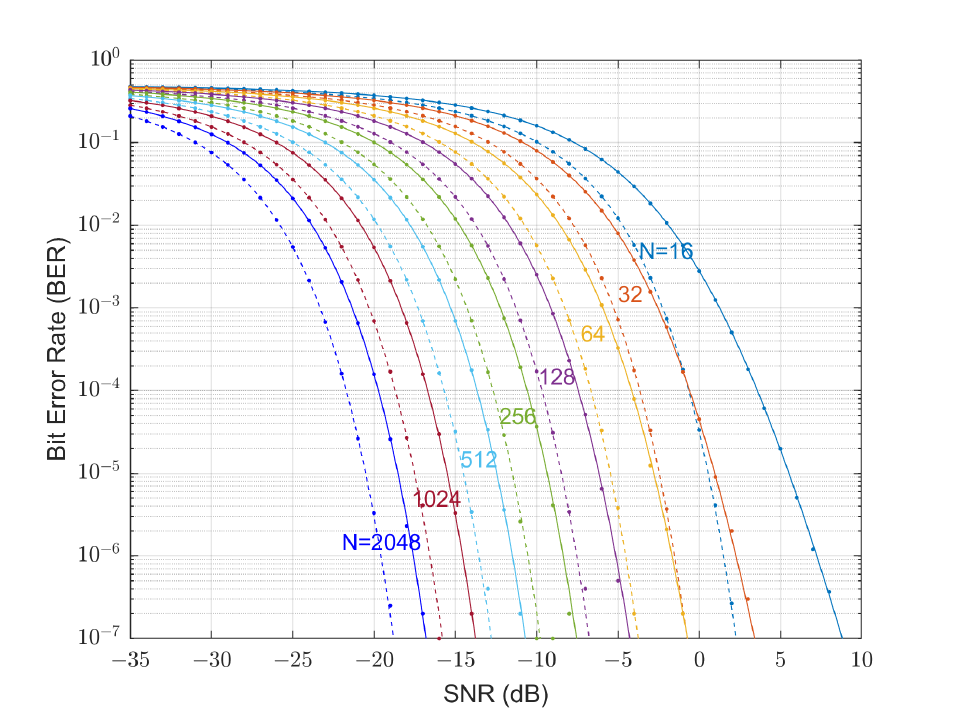
Figure 14. Uncoded BER performance: theoretical QPSK GDSS (solid lines) and QPSK DSSS (dashed lines) with various spreading factor N , and corresponding simulation results (dots).